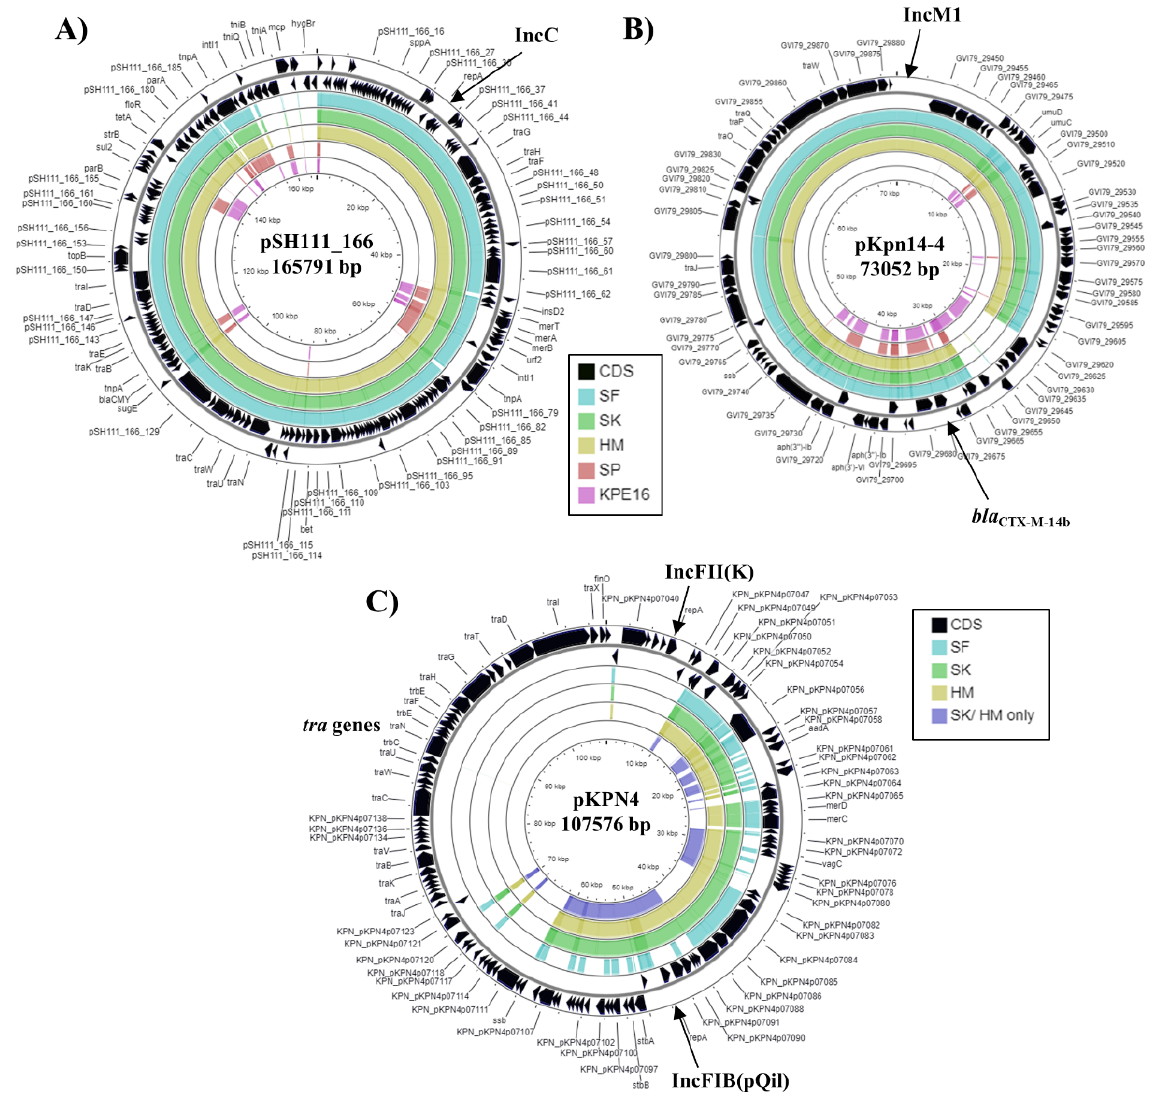
Figure 3. Analysis of plasmids carried by K. pneumoniae strains SF, SK, and HM. The figure shows the comparison of ( A ) Salmonella enterica subsp. enterica serovar Heidelberg plasmid pSH111_166 (JN983043.1) [46], ( B ) K. pneumoniae plasmid pKpn14-4 (CP047704.1) [15] and ( C ) K. pneumoniae MGH 78578 plasmid pKPN4 (CP000649.1) [30] with the genomes of K. pneumoniae strains SF, SK, HM, SP and KPE16, using GCview [32]. In all panels, the outer two rings display the genes (CDS) of each plasmid on both strands, with plasmid replicons labelled. In panels ( A , B ) the blue, green, gold, red, and pink shading illustrates the BLAST results when the genome sequences of SF, SK, HM, SP, and KPE16, respectively, are compared with each plasmid. In panel ( C ), the light blue, green, gold, and dark blue shading illustrates the BLAST results when the genome sequences of SF, SK, HM and the contigs that are specific to SK/HM only (after genome subtraction) are compared to pKPN4. Shaded regions indicate